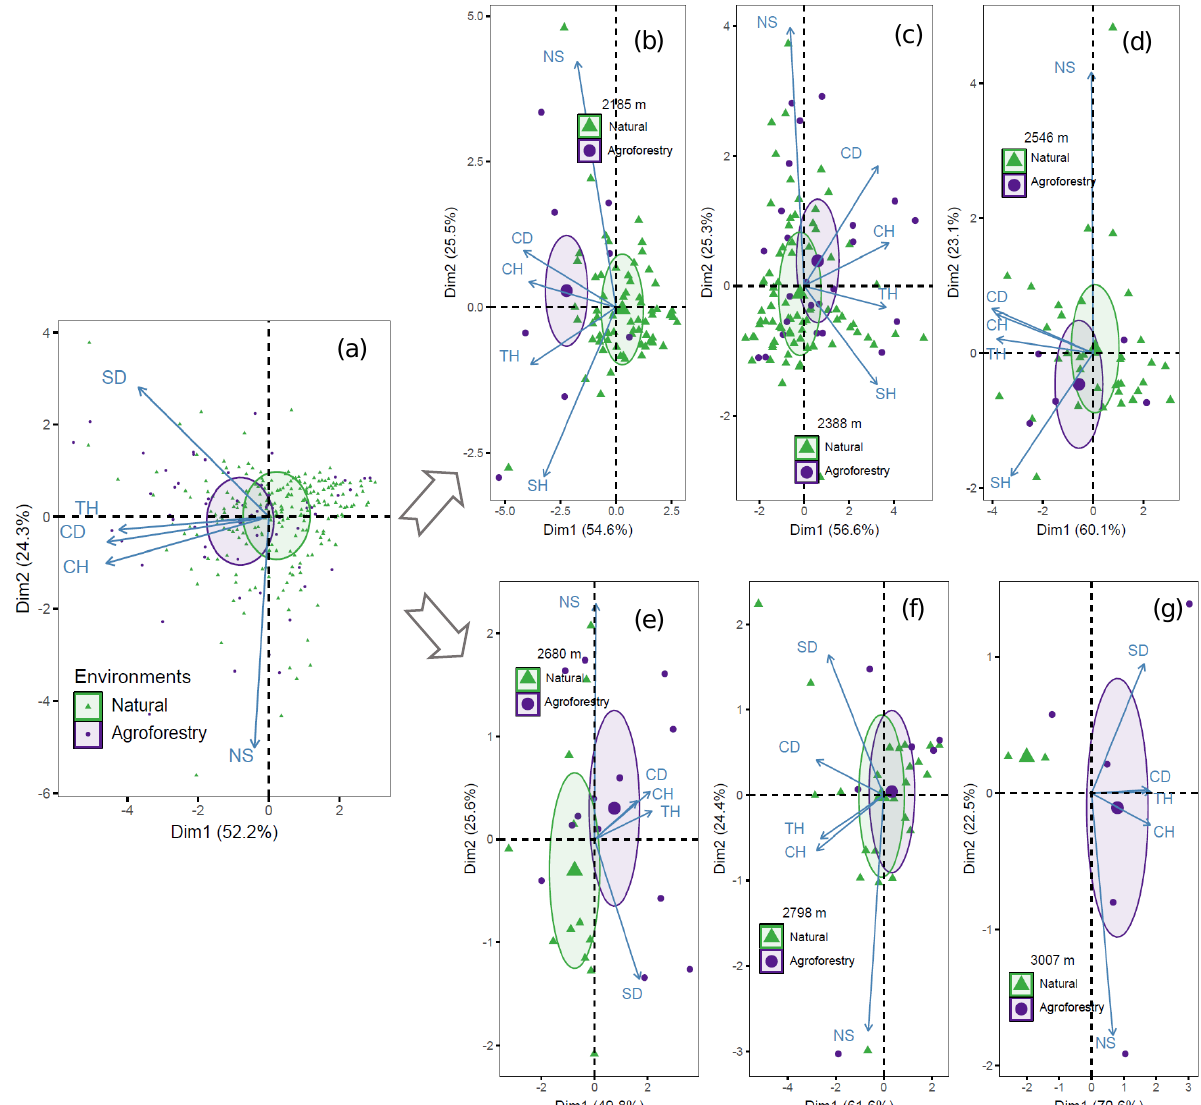
Figure 5. Principal component analysis (PCA) of the number of stems (NS), crown diameter (CD), tree height (TH), crown height (CH), and stem diameter (SD) of Tara. All plots ( a ), altitude 2185 m ( b ), altitude 2388 m ( c ), altitude 2546 m ( d ), altitude 2680 m ( e ), altitude 2798 m ( f ), and altitude 3007 m ( g ); for natural and agroforestry environments.